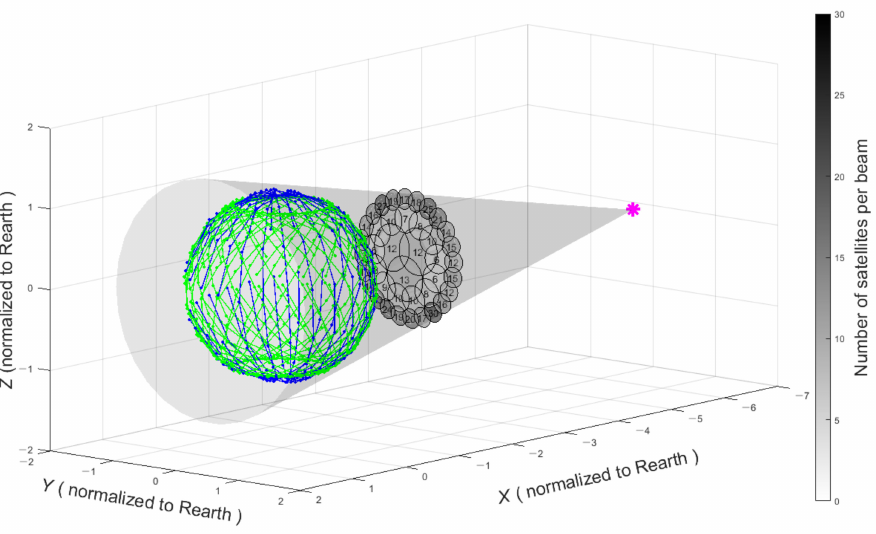
Figure 1. Schematic of a GEO data relay satellite covering the target LEO satellite constellation with spot beams. The LEO satellites are located within a field of view (FOV) of approximately ± 11 ◦ . The number in the center of each circle indicates the objective LEO satellites in the coverage of the certain beam (Rearth is the radius of the